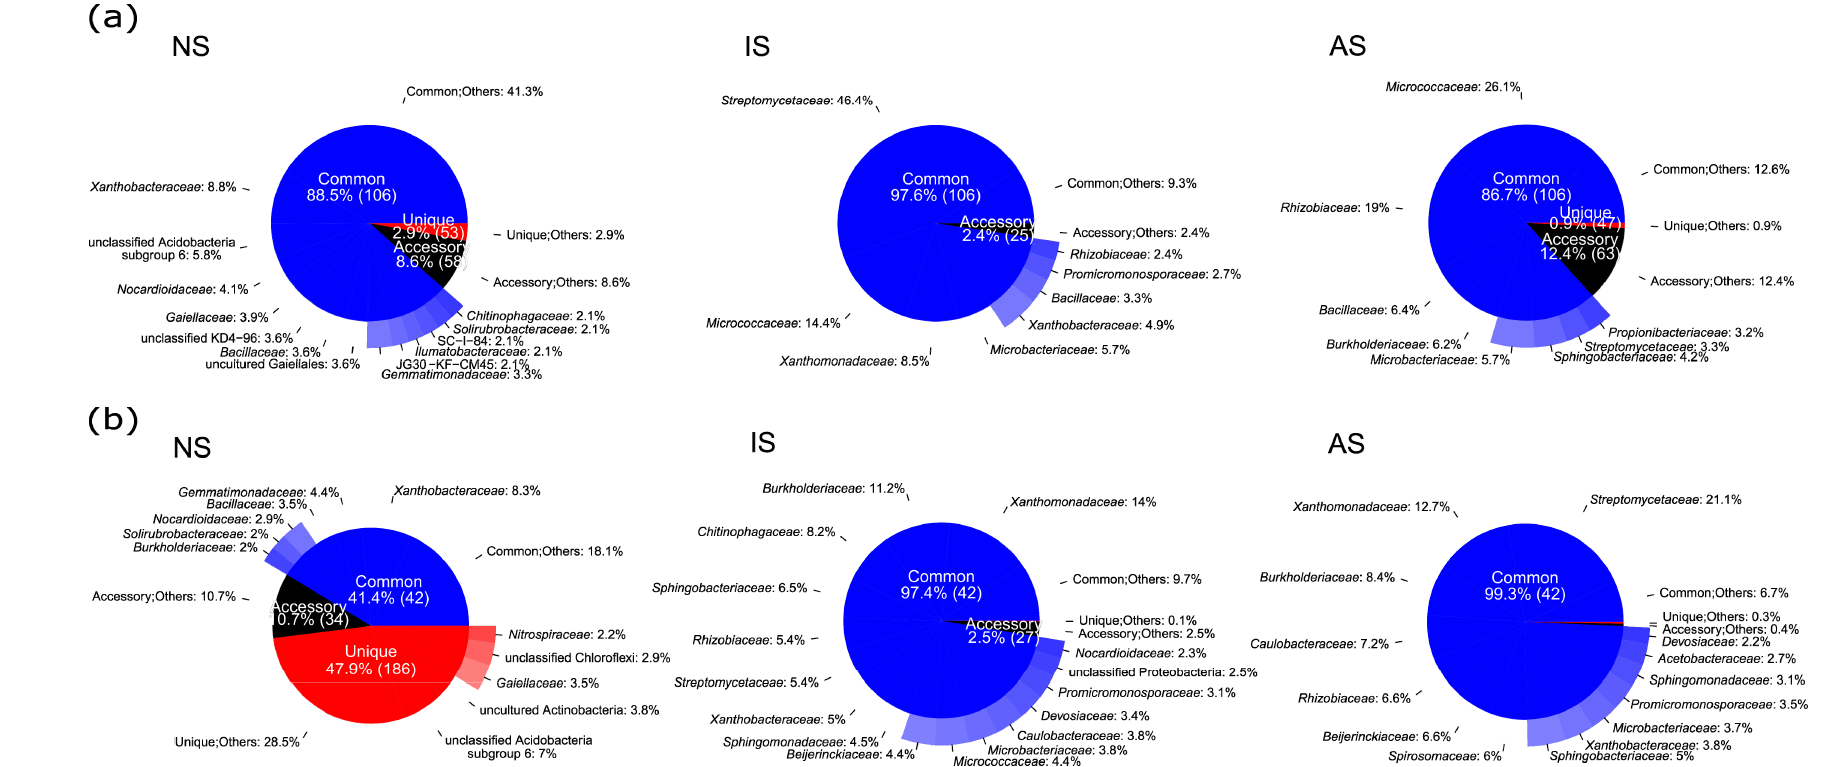
Figure 5. Mean relative abundance of bacterial families in different soil treatments (NS: natural soil, IS: inoculated soil, and AS: autoclaved soil) at two different time points ( a : week 0 and b : week 6). Colors indicate three categories (blue as “Common”, black as “Accessory”, and red as “Unique”). Bacterial families found across all soil treatments are defined as “Common”, those unique to a soil are represented as “Unique”, with the remaining grouped as “Accessory”. Percentage shows the average relative abundance of each family ( n = 3). “Common;Others”, “Unique;Others”, and “Accessory;Others” contain common/unique/accessory bacterial families that are less than 2% in relative abundance. The numbers in brackets show the number of bacterial families detected in each category.